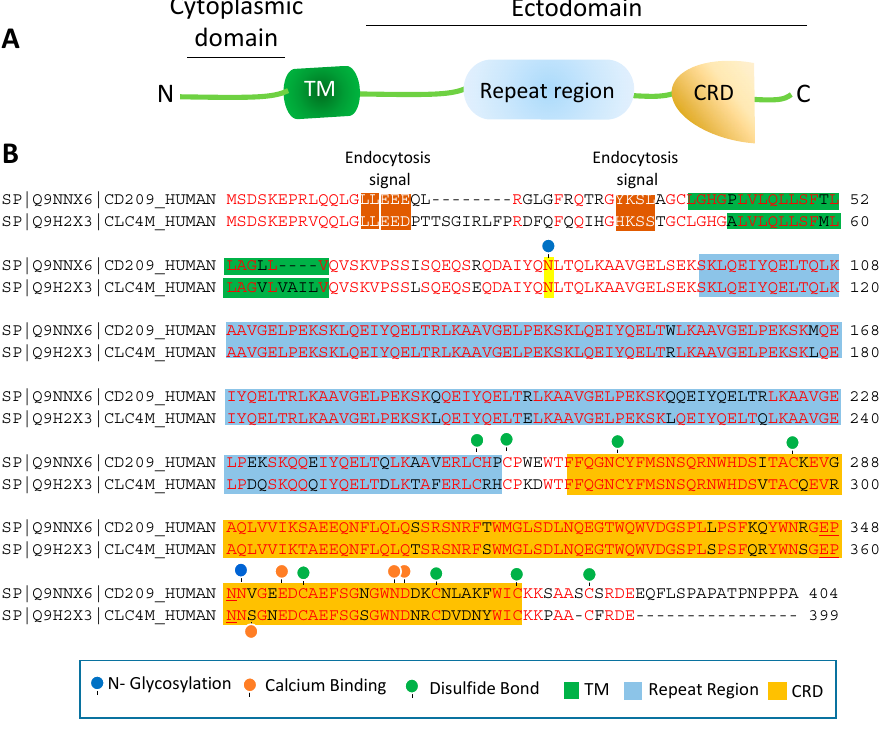
Figure 2. Amino acid sequence homology of CD209 and CD209L: ( A ) The schematic of CD209L is shown. ( B ) Alignment of the amino acids of human CD209 and CLEC4M (gene encoding for CD209L called C-type lectin domain family 4 member M, CLEC4M). The key common features of CD209L and CD209L, including potential PTMs and ion bindings are